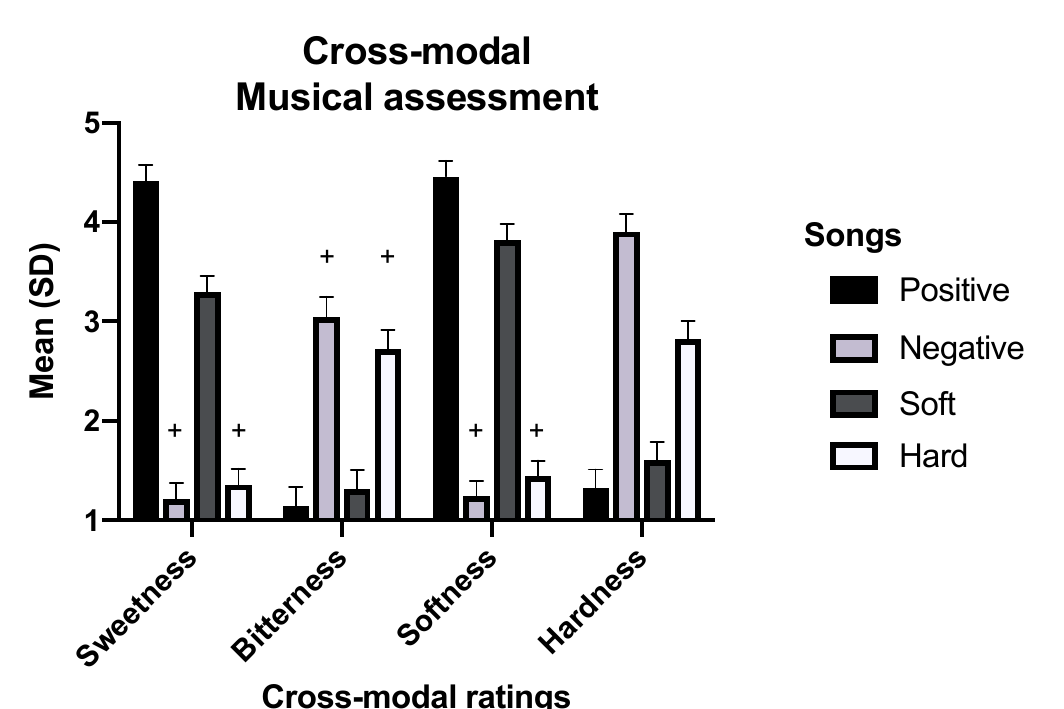
Figure A1. Summary of cross-modal ratings during the pre-test of the songs. Bars represent the mean values with corresponding standard deviations (SD). Plus signs show the only pairs of bars where there was no significant difference between such means at 95% confidence.